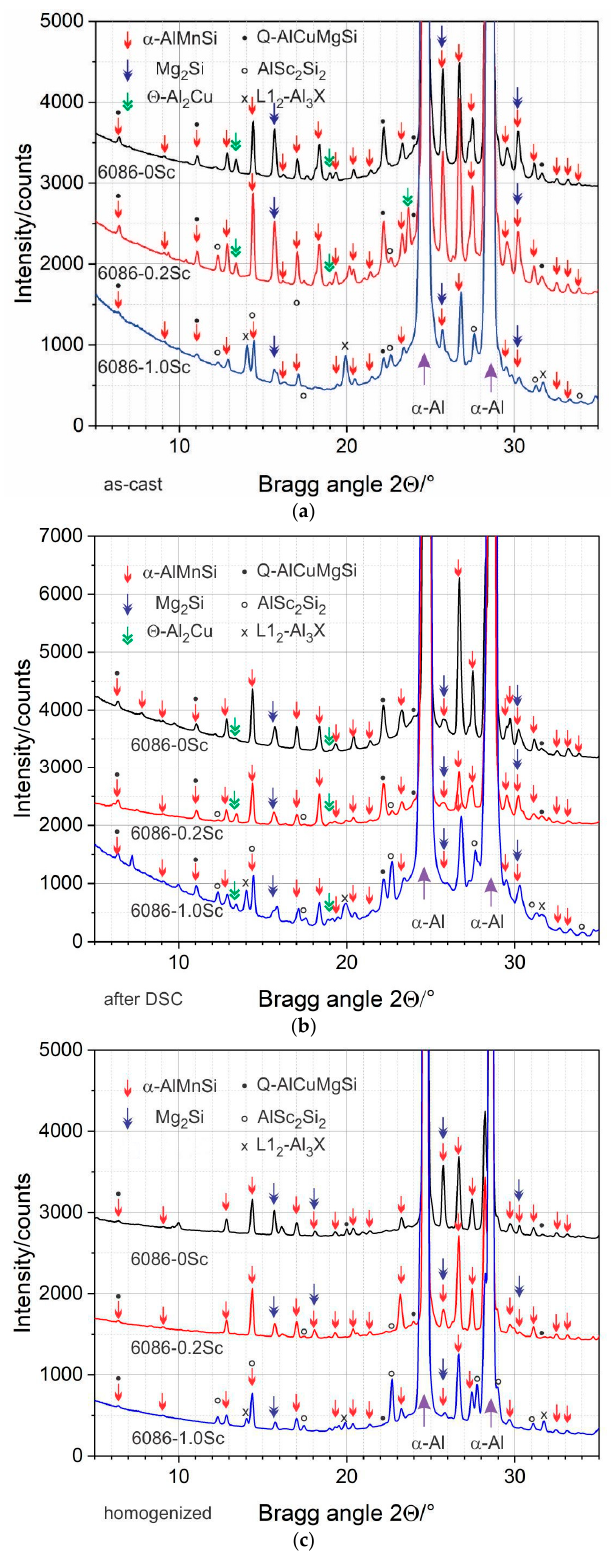
Figure 6. XRD patterns of the investigated alloys in the ( a ) as-cast condition, ( b ) after DSC, and ( c ) after